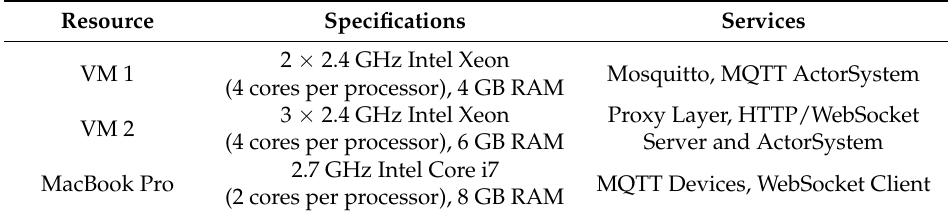
Table 2. Resources used in the emulation setting and service